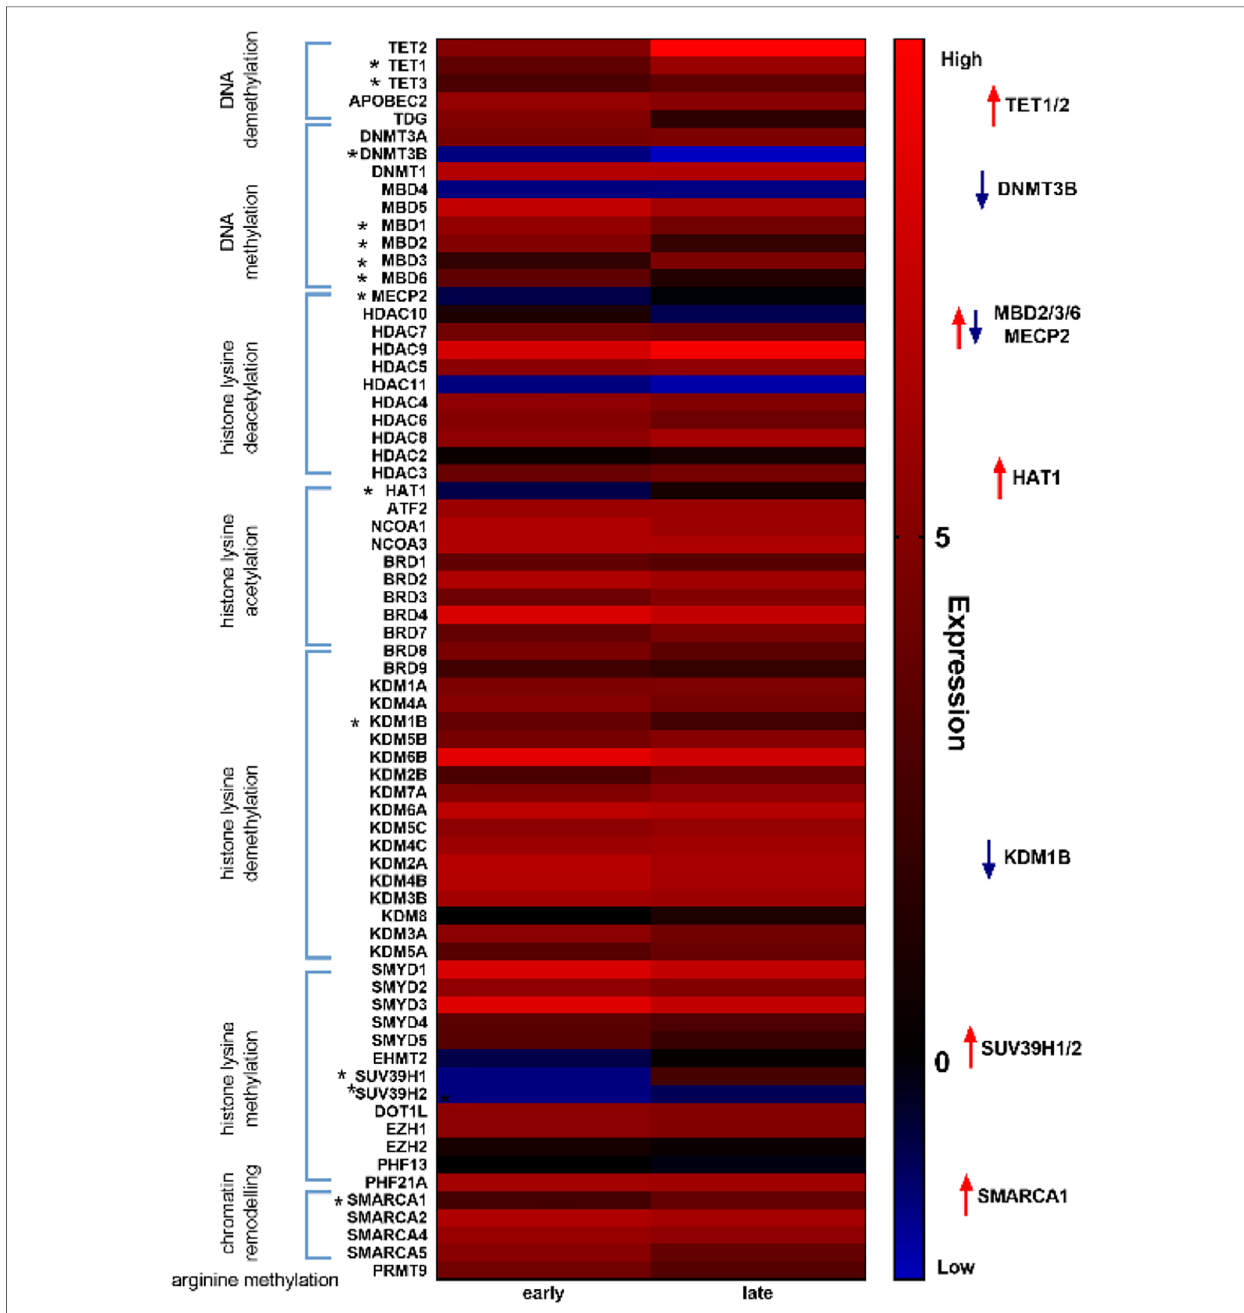
FIGURE 2 Heat map analysis of epigenetic markers revealed distinct differential regulation of DNA methylation modi fi ers in early vs. late cardiotoxicity in myocardial patient biopsies. Heat map showing upregulation of genes involved in DNA demethylation (e.g., TET1/2) and downregulation of genes involved in DNA methylation (e.g.,